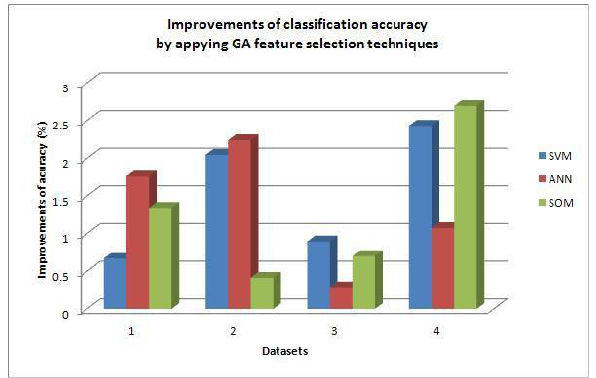
Figure 5. Improvements of accuracy by applying FA-GA techniques for SVM, ANN and SOM classifiers.